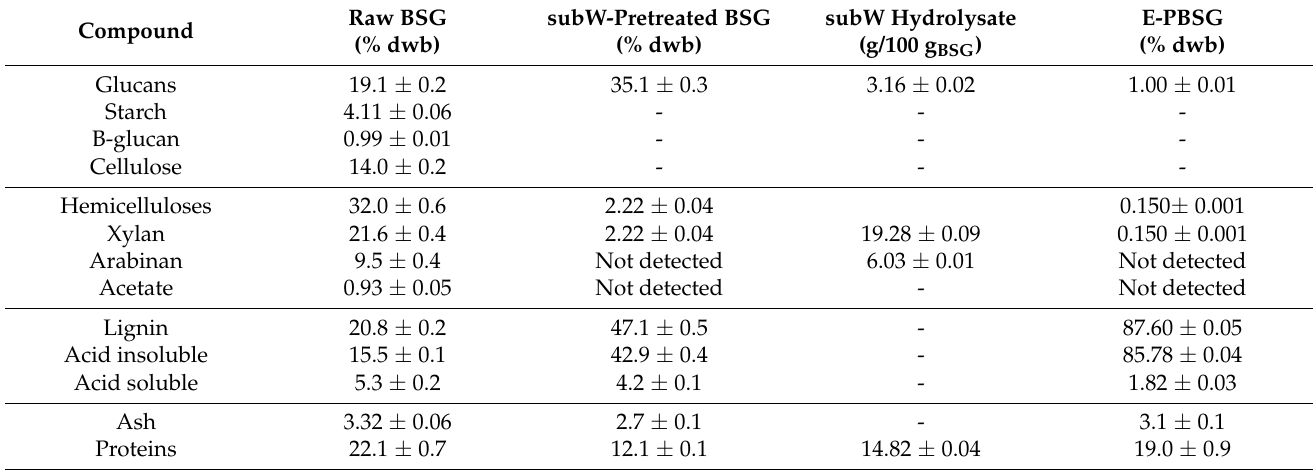
Table 1. Chemical composition of raw BSG, subW-pretreated BSG, solid residue remained after